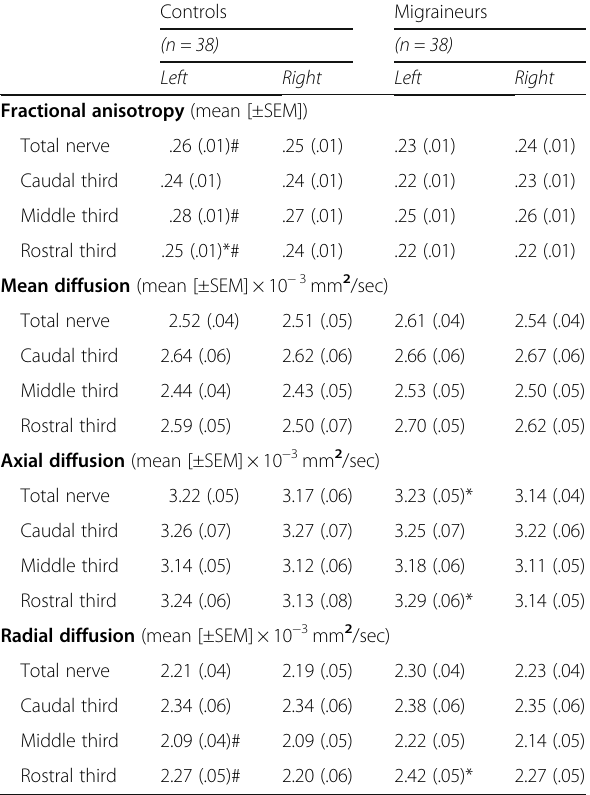
Table 2 Fractional anisotropy, mean diffusion, axial diffusion and radial diffusion values of the trigeminal nerve root entry zone in control and migraine subjects. Total nerve as well as caudal, middle and rostral third values are shown. * p < 0.05, significant within group difference between left and right nerve volumes. # p < 0.05, significant between group difference between left and right nerve volumes